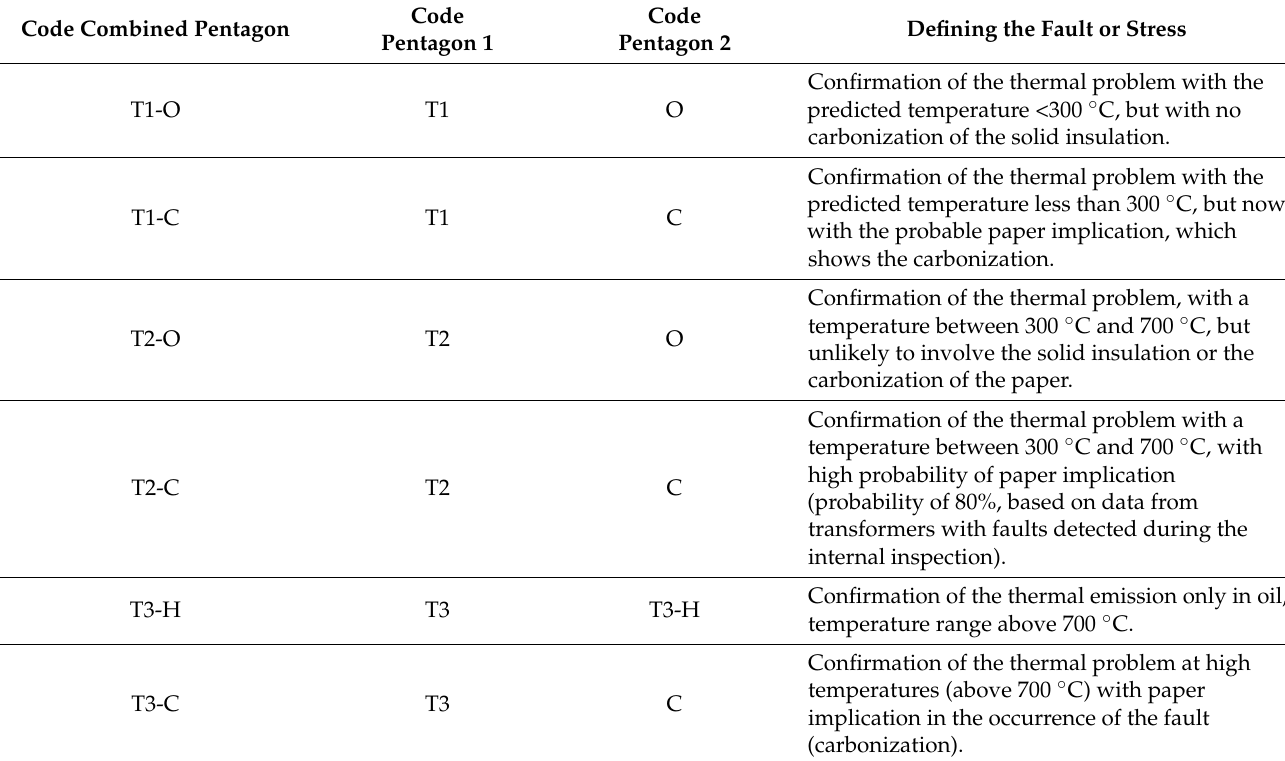
Table 7. Defining the areas of thermal faults in the Combined Duval Pentagon.